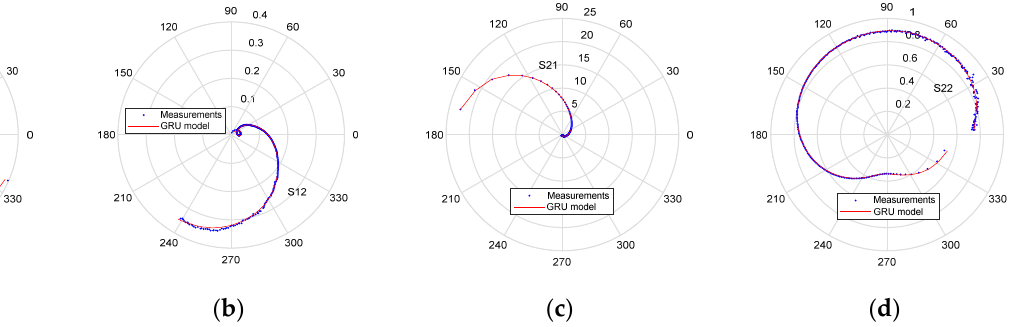
Figure 14. Measured (blue symbols) and GRU simulated (red lines) behavior of ( a ) S 11 , ( b ) S 12 , ( c ) S 21 , and ( d ) S 22 with the frequency range spanning from 200 MHz to 65 GHz for the DUT at V DS = 30 V, V GS = − 3.1 V, and T a = 35 °C.